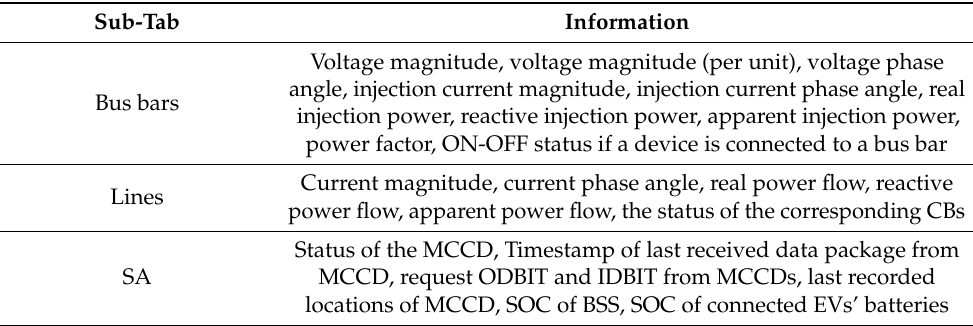
Table A3. Description of sub-tabs of GUI’s online monitoring